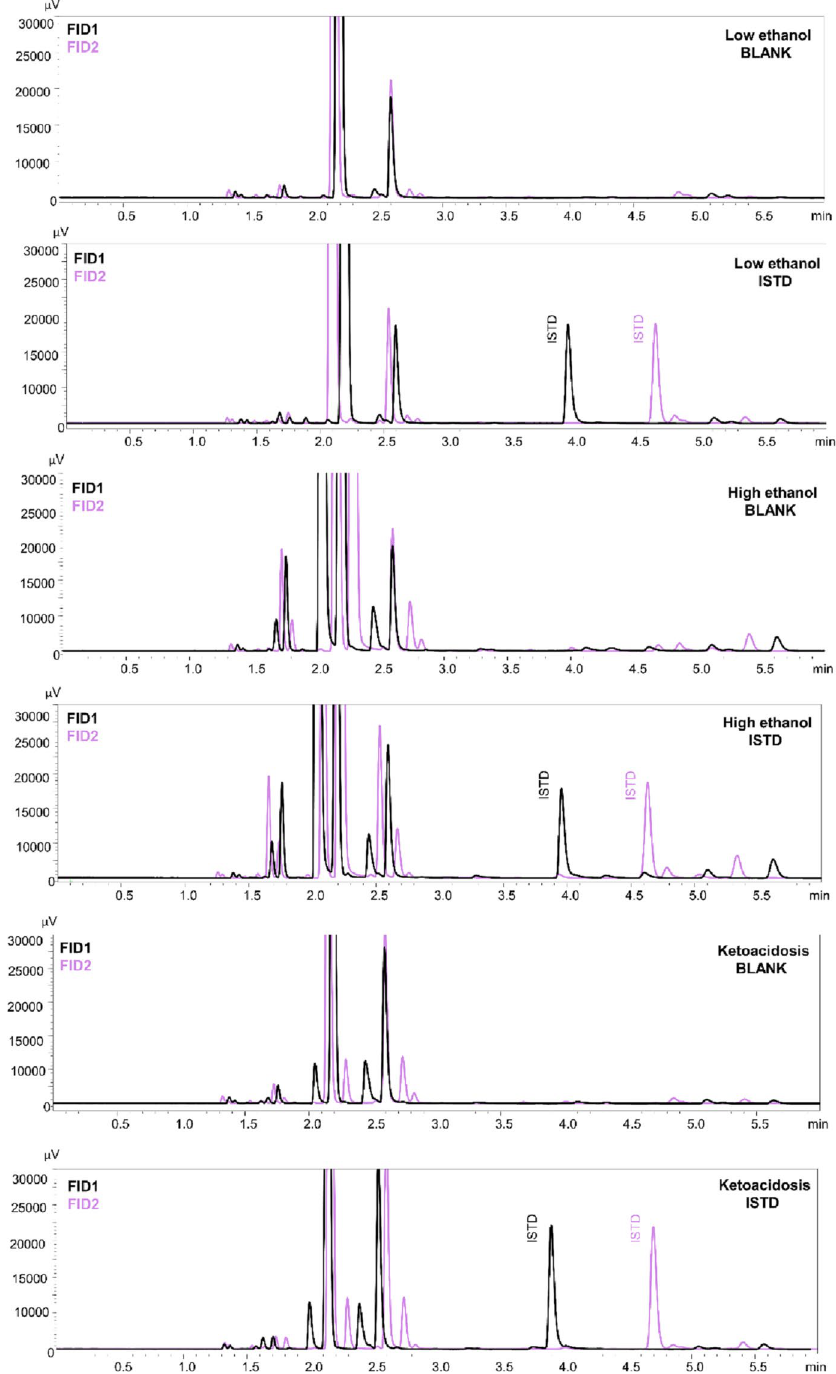
Figure 4. Selectivity of the method with regard to endogenous substances contained in the samples in case of low ethyl alcohol content (below 0.5‰), high ethyl alcohol content (more than 4‰) and ketoacidosis. Black line is illustrating result from FID1 and violet line from